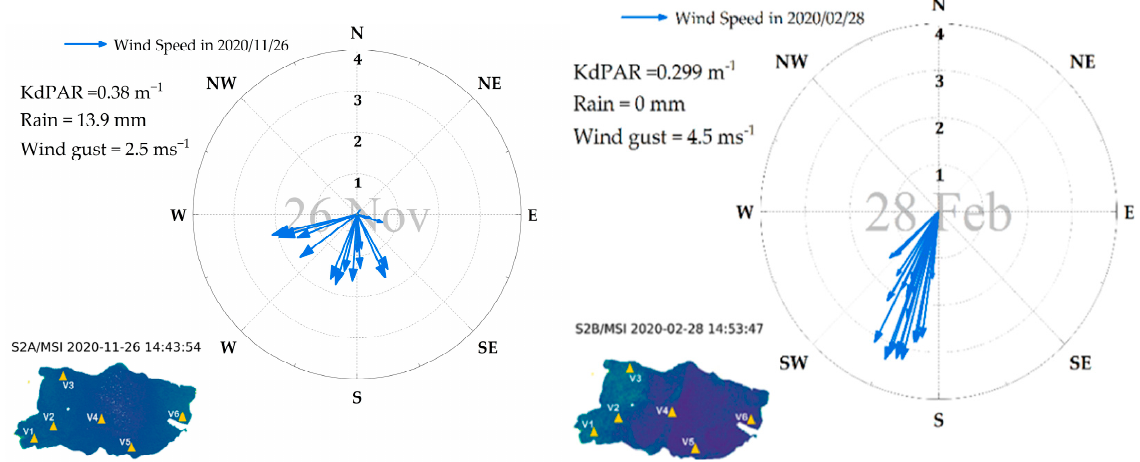
Figure 6. KdPAR and its relationship with wind speed, gust speed, wind direction, and rain on selected days.